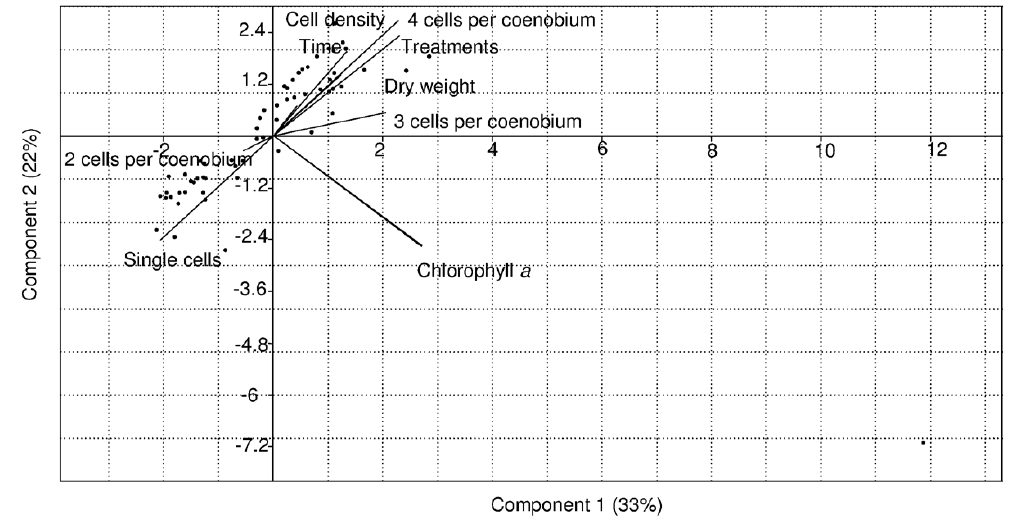
Fig. 6 - Principal components analysis (PCA) biplot showing the correlation between different growth, biomass and morphological parameters of Scenedesmus quadricauda exposed to different indigo dye effluent